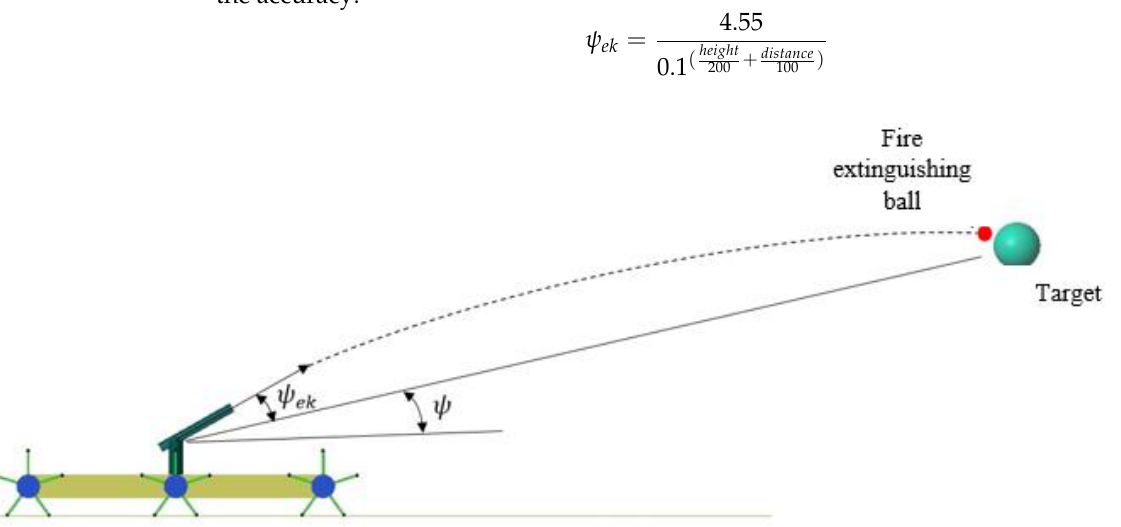
Figure 11. The oblique shot movement of the fire-extinguishing ball leaving the barrel.